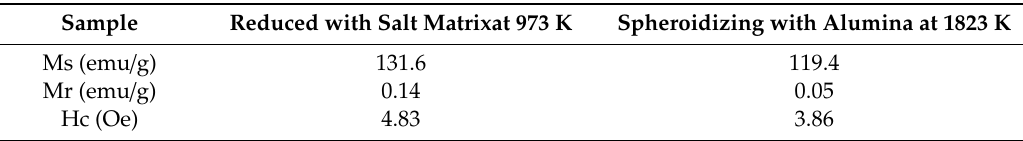
Figure 5. M-H hysteresis loop curve of pre-alloy and spherical Fe 50 Ni 50 alloy powder. Inset: Enlarged view of coordinates. Table 2. The magnetic parameter of the reduced pre-alloy powders and the spherical alloy powders for comparison.